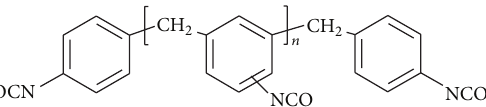
Figure 2: Polymeric methylene diphenylene diisocyanate